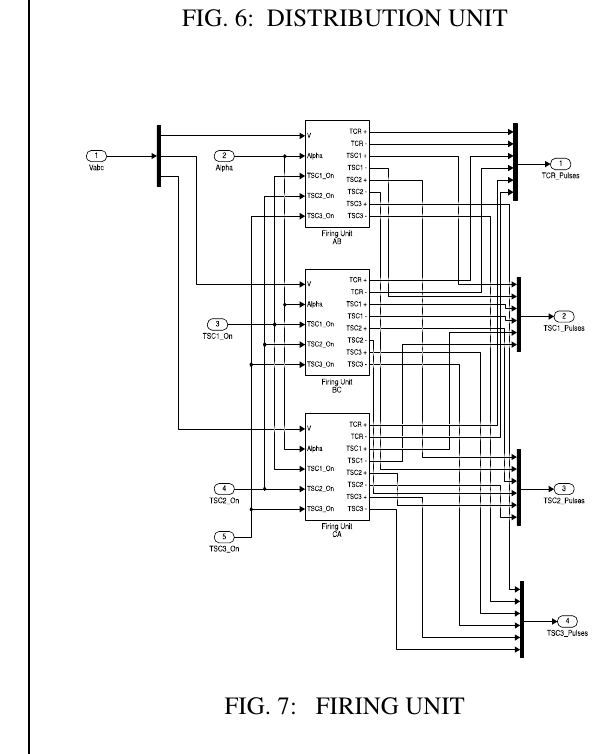
FIG. 6: DISTRIBUTION UNIT